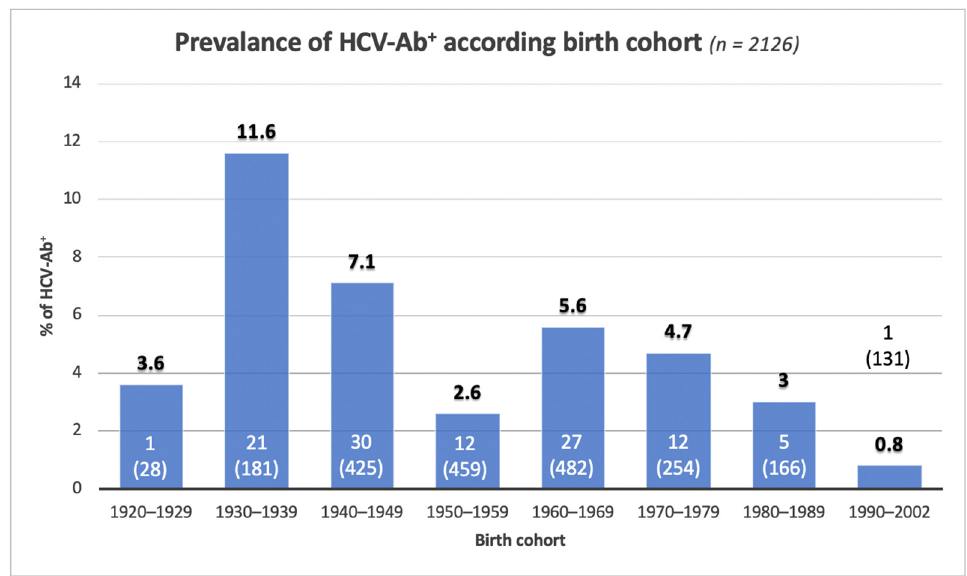
Figure 1. HCV-Ab seroprevalence, according to the birth cohort. In columns: numbers in parenthesis indicate the total number of screened subjects; number not in parenthesis indicate the number of positive cases.